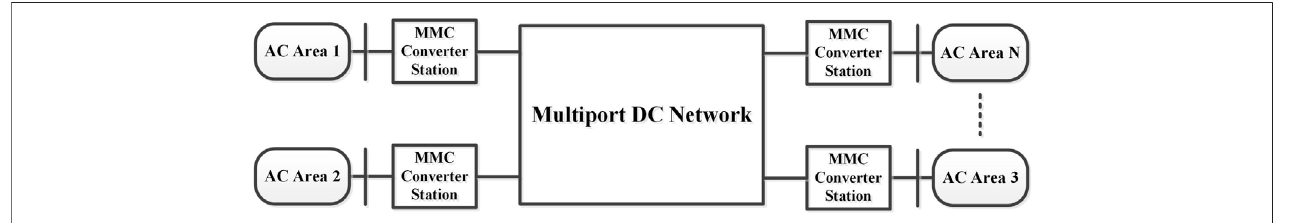
FIGURE 3 | Framework of the MMC – MTDC